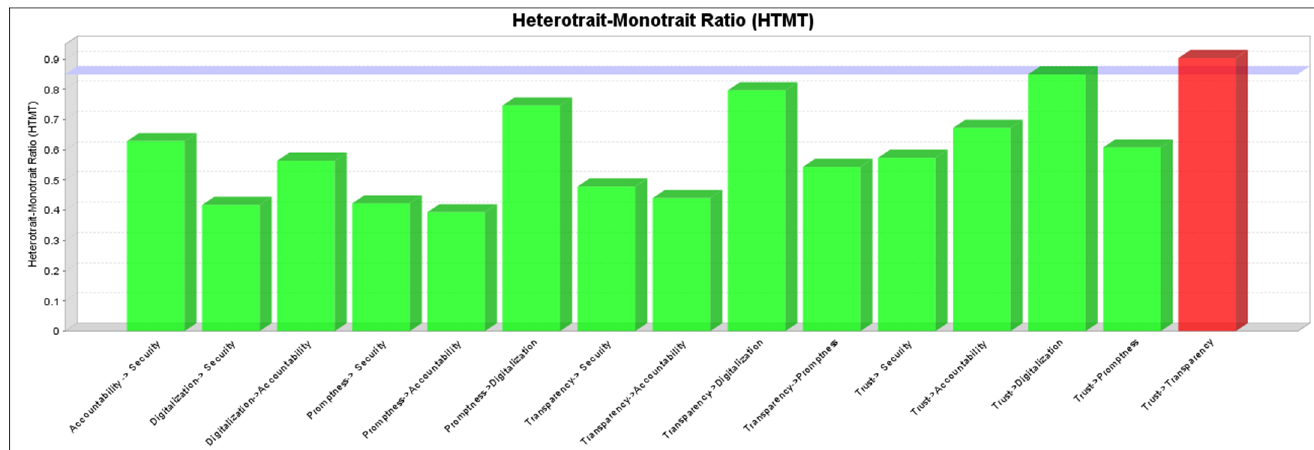
Table 3. Fornell-Larcker Criterion and Correlation.